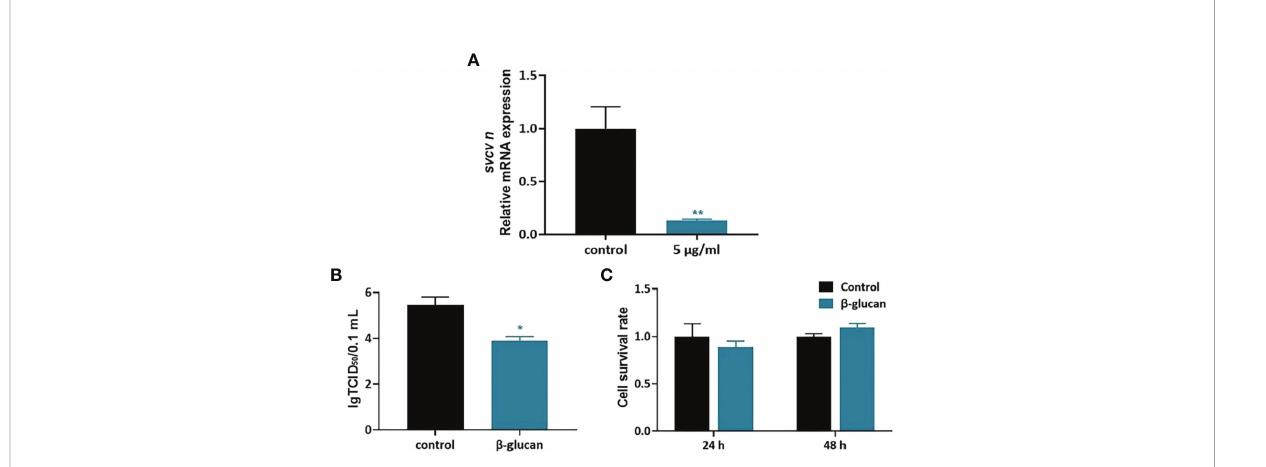
FIGURE 4 Antiviral effect of b -glucan in ZF4 cells. (A) Effects of b -glucan in the mRNA expression of SVCV N protein (n = 6); (B) Effects of b -glucan on the TCID 50 of SVCV (n = 6); (C) Effects of b -glucan on cell viability (n = 6). Values represent the means ± SEM. * P < 0.05; ** P <